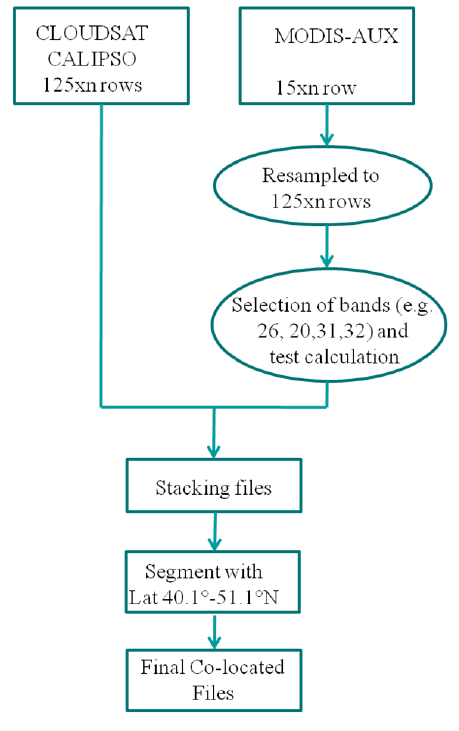
Figure 1. Flowchart for the pre-processing phase for the co-location of MODIS, CloudSat and CALIPSO